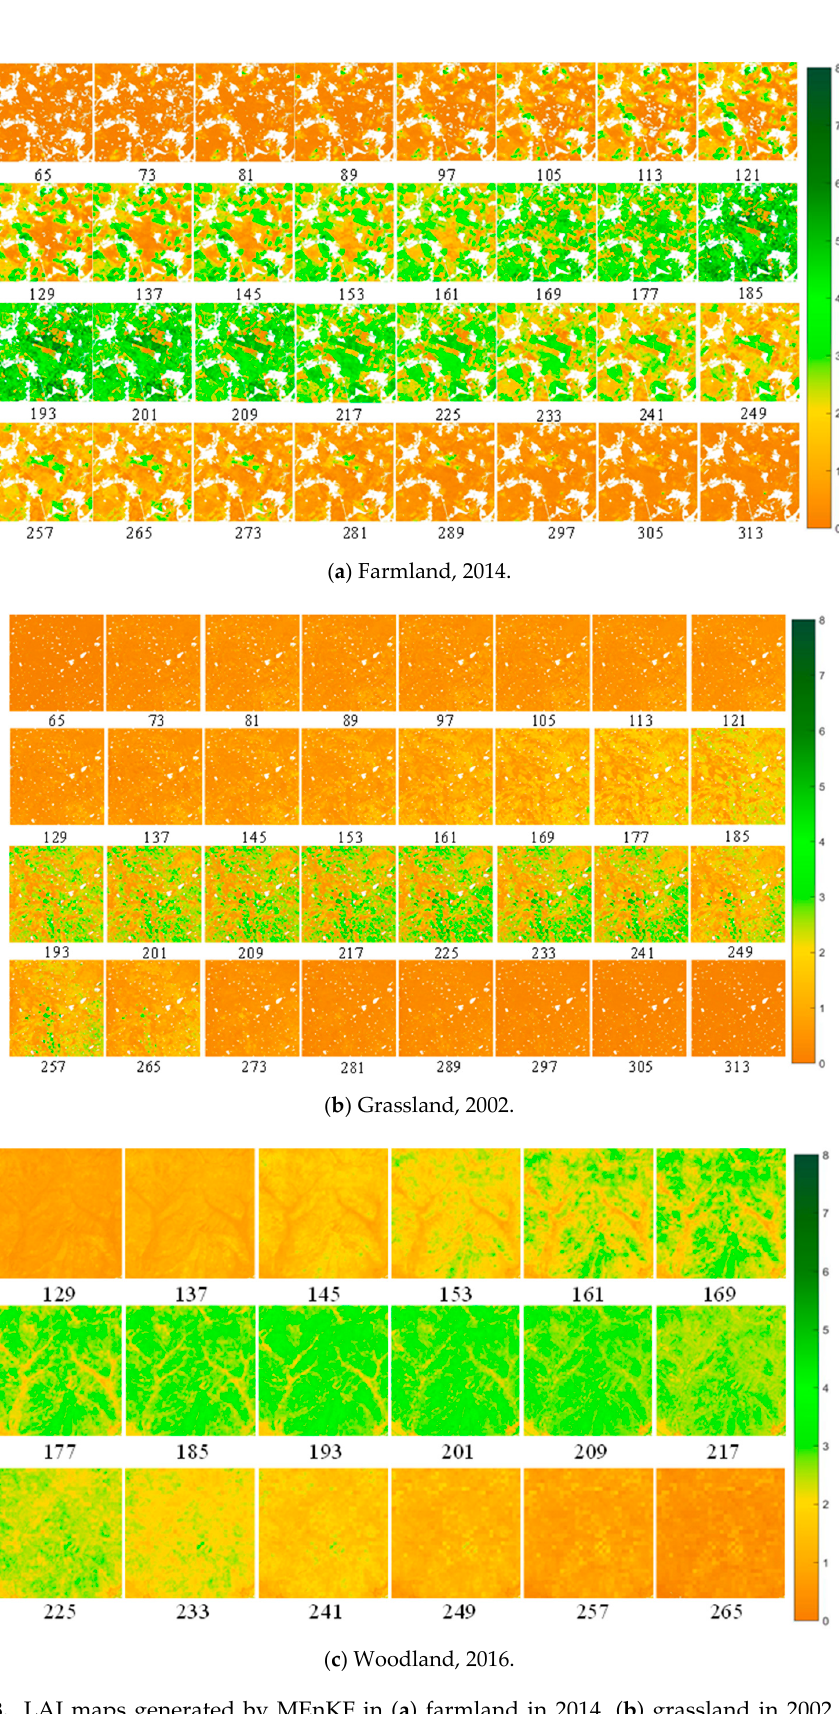
Figure 8. LAI maps generated by MEnKF in ( a ) farmland in 2014, ( b ) grassland in 2002, and ( c ) woodland in 2016. Each LAI map is marked with the corresponding day of the year (DOY).